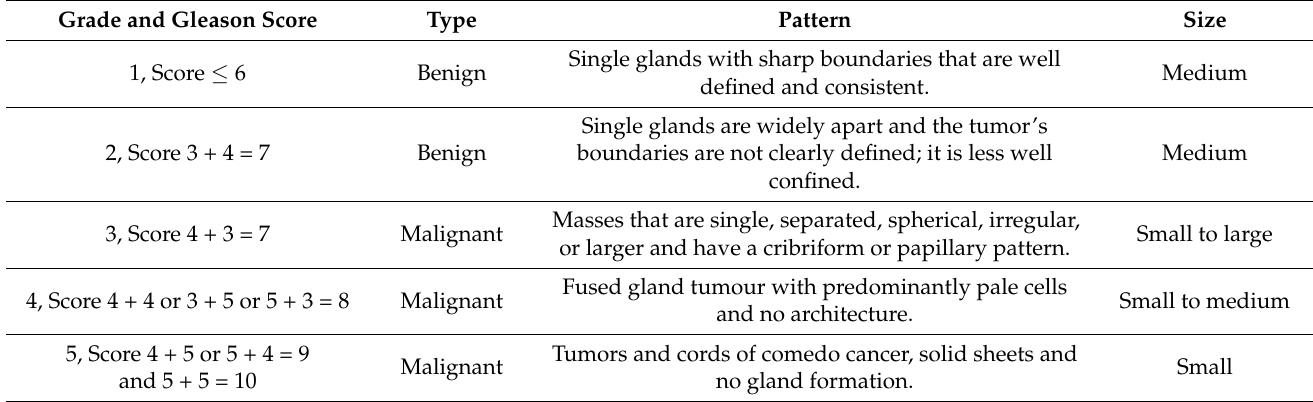
Table 2. Classification of Gleason grading system with histopathological PC